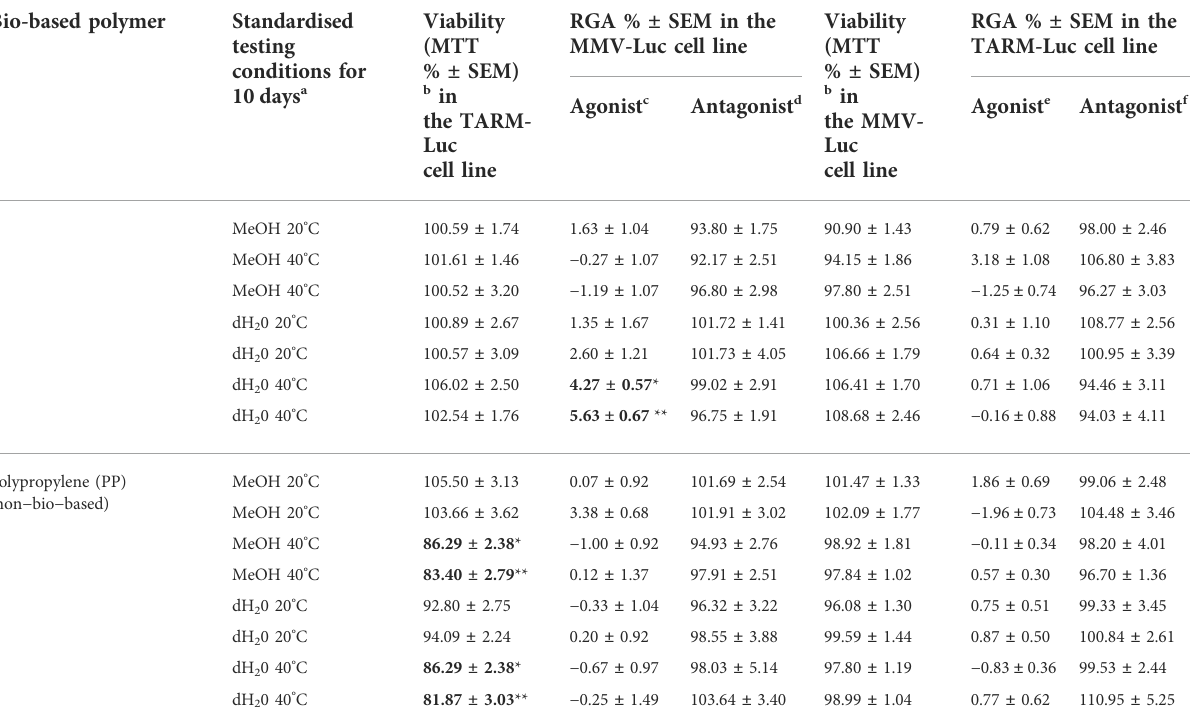
litter ash/polypropylene (10:90) in MeOH at 40 ° C exhibited an antagonistic effect in the TARM-Luc (androgen and progestagen responsive) cell line, with 11.02 and 19.49% reduction in androgen nuclear receptor transcriptional activity ( p ≤ 0.01 and p ≤ 0.001, respectively) as shown in Figure 4. This reduction in androgen nuclear receptor transcriptional activity can be identi fi ed as true antagonism as no signi fi cant reduction in MTT metabolic activity was seen in the MTT assay (data not shown). A summary of the results for the samples which leached compounds that exhibited a reduction in metabolic activity or an (ant)agonistic response in the MMV-Luc (estrogen responsive) or TARM-Luc (androgen responsive) cell lines are presented in Table 4. Table 4 excludes the results from the TM-Luc (progestagen responsive) cell line as no (ant)agonist activity or gross cellular cytotoxicity was detected for any of the bio-based polymers tested at any of the standardised testing conditions. The bio-based polymer leachates that did not exhibit gross cellular cytotoxicity or an (ant)agonistic response in any of the RGA